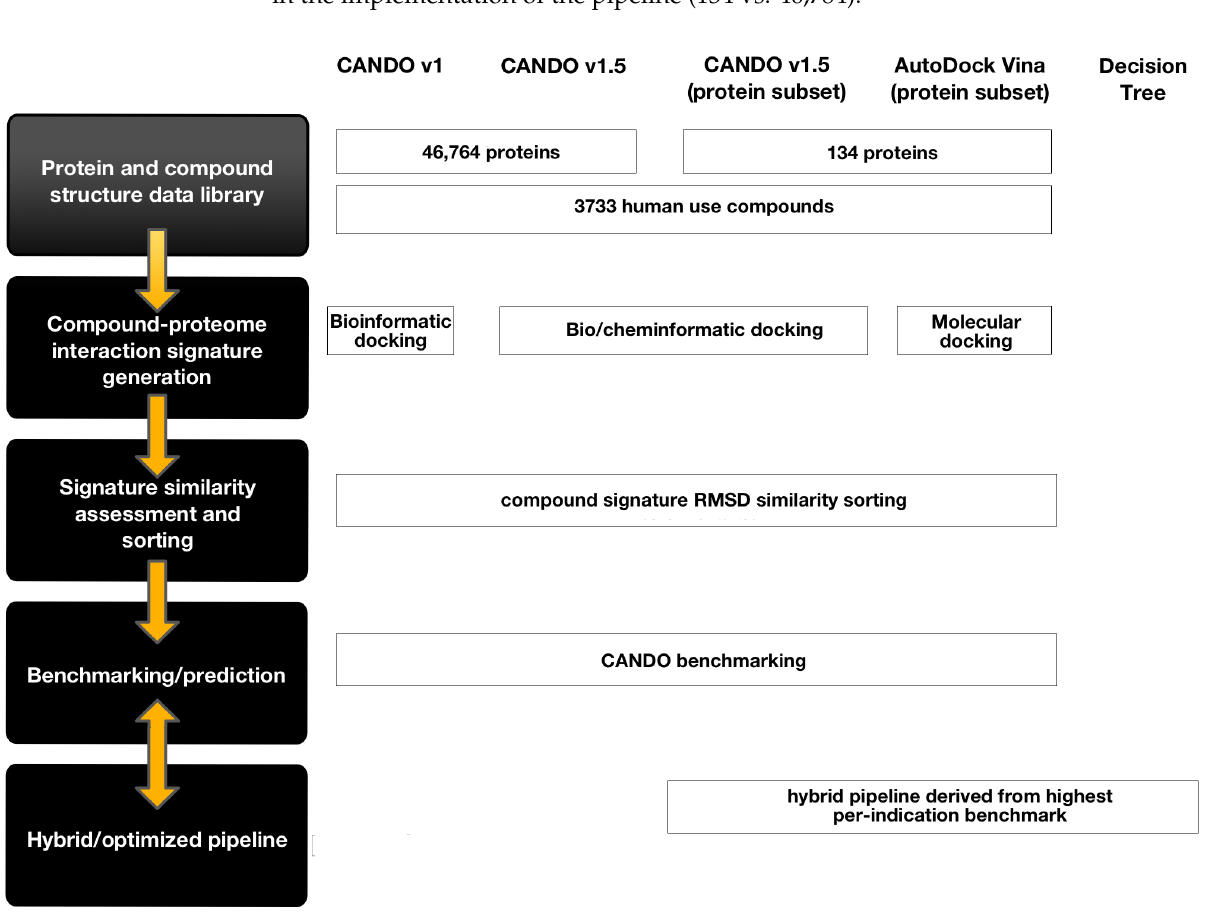
Figure 1. CANDO shotgun drug repurposing platform and pipeline overview. On the left side of the figure is a flow diagram, which indicates the general protocol for implementing a CANDO drug-proteome pipeline. To the right of the flow diagram, each pipeline relevant to this investigation is displayed along with implementation details for each phase of the CANDO protocol. Data curation: The drug-proteome pipelines utilize libraries of protein structure and drug structure representations. Interaction scoring protocol: These pipelines use bioinformatic, cheminformatic, and molecular docking methods to predict the scores between each protein and drug interaction. The set of protein interaction scores for each drug is considered its interaction signature. Each interaction signature can be compared with one another by assessing the root mean squared deviation of their interaction signatures. Drug comparison protocol: Every drug signature is compared with every other drug signature. After every comparison is made, each drug has a list containing the ordered set of every other drug, from most similar signature to least similar signature. Benchmarking protocol: The CANDO benchmarking procedure assesses, for every drug, how many other drugs with the same indication association are found within certain ranking cutoffs. An indication-specific accuracy score is produced by averaging the recovery rate of co-associated drugs for every drug associated with the particular indication for particular ranking cutoffs. The overall pipeline average indication accuracy is the mean of all the individual ones for a particular cutoff. Three pipelines were generated during this investigation: v1.5 (implemented with a subset of the CANDO proteome library), AutoDock Vina (using the same proteome sublibrary), and a hybrid decision tree pipeline derived from the former two pipelines. Each of the subset pipelines utilized a small sublibrary (134 proteins) of the original CANDO v1 and v1.5 pipelines. Although the pipelines used different signature generation approaches (BANDOCK bioanalytical or similarity docking and AutoDock Vina molecular docking), their signatures underwent the same similarity assessment and benchmarking protocol. However, there is room for variation via the use of alternate docking, similarity assessment, and benchmarking